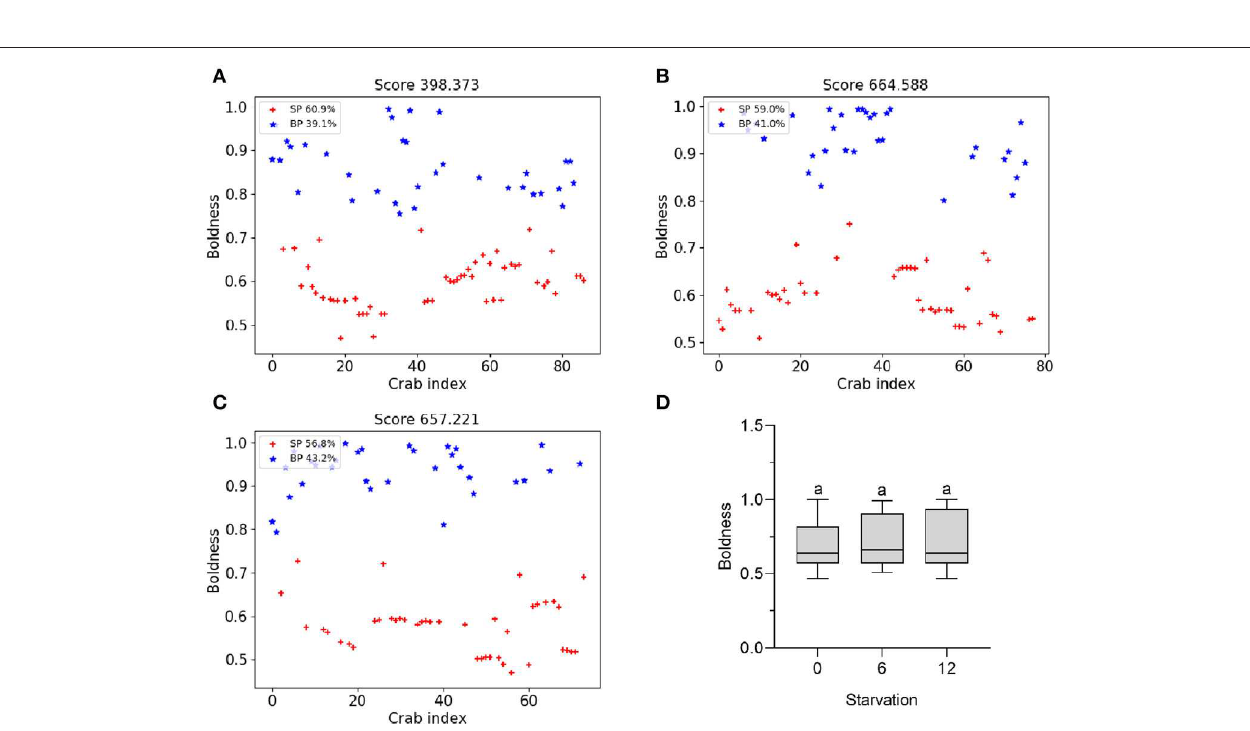
FIGURE 3 | Clustering result based on boldness. (A) Result under 0 day starvation. (B) Result under 6 days starvation. (C) Result under 12 days starvation. (D) Changes in boldness under different starvation conditions.